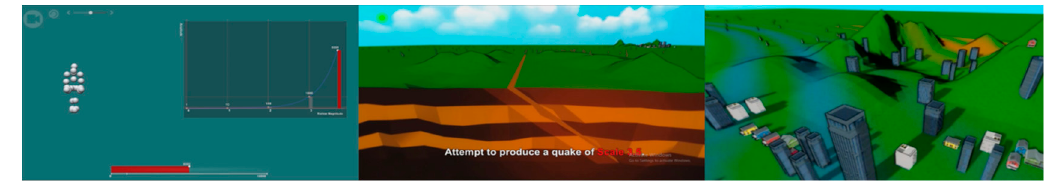
Figure 3. Three-screen layout of the simulation showing gesture tracking skeleton and graph visualizations ( left ), earthquake mechanisms and tasks ( center ), and earthquake effects ( right ).